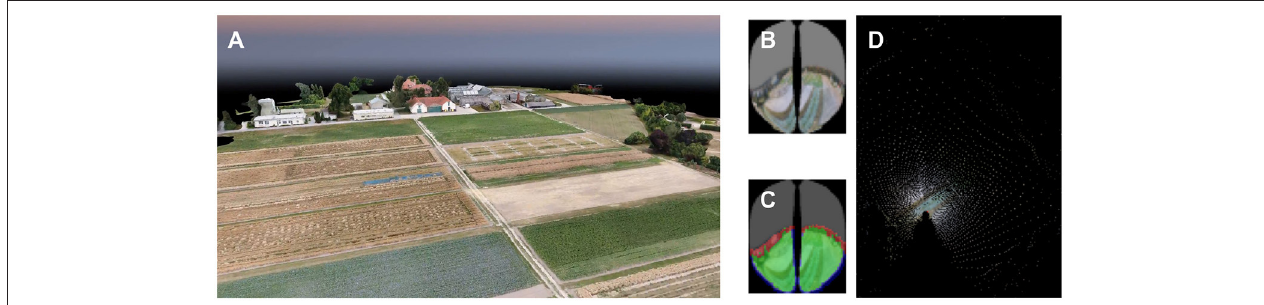
FIGURE 6 | Mapping of a honey bee’s vision at one position. (A) 3D rendering from the photogrammetric model of the experimental landscape. (B) The reconstructed honey bee’s perception of the field. To draw this perspective onto a map, the location of each pixel in the photogrammetric model is calculated. (C) Only pixels that show a part of the field are used for mapping, which are marked as green in image Red pixels show parts of the environment outside the field. They are not used for mapping as well as blue pixels which lead to artifacts after mapping. (D) Ray casting is used to model the locations in the field perceived by the individual and placed on a map of the field. Each mapped pixel is assigned the same color as in the bee